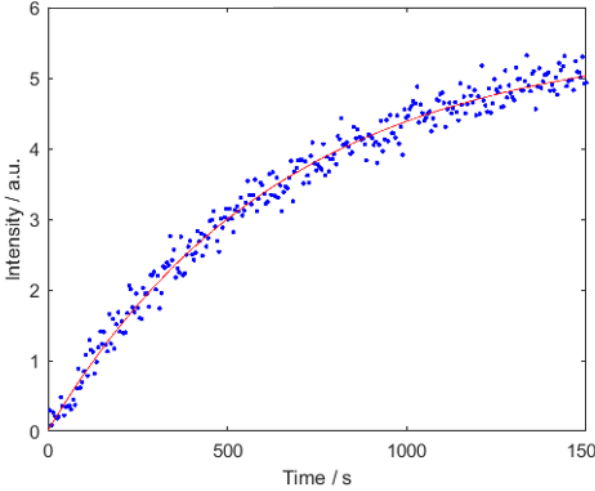
Figure 6. Polarization build-up curve at 1.8K. The build-up rate constant was 0 . 0016 ± 0 . 0001s − 1 . The polarization was of P ( 1 H) ≈ 15 ±−